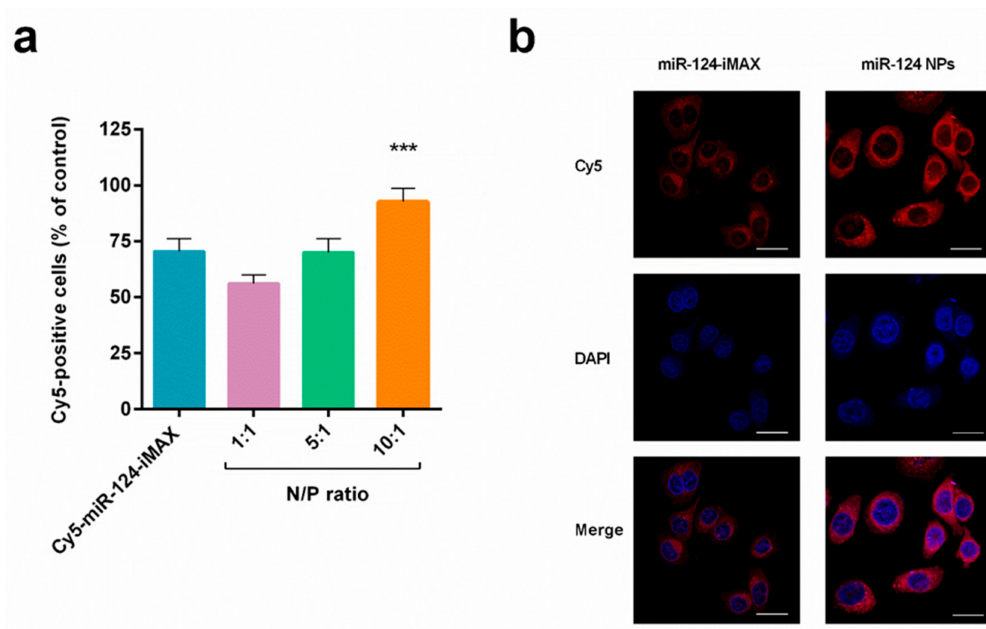
Figure 3. Intracellular delivery e ffi ciency of PHB-PEI NPs / miR-124 complexes. ( a ) PC3 uptake of miR-124 NPs analyzed by Fluorescent Activated Cell Sorting (FACS). To facilitate observations, miR-124 was labeled with the Cy5 fluorescent probe (red) to form Cy5-miR-124-NPs at di ff erent N / P ratios (1:1 to 10:1). Lipofectamine RNAiMAX (iMAX) was used as a control. Cells were incubated with fluorescent nanocomplexes for 4 h, washed with PBS, and incubated for another 20 h prior to analysis by flow cytometer (mean ± SD, n = 6). Statistically significant variations: *** p < 0.001 N / P 10:1 versus N / P 5:1, N / P 1:1, and iMAX. ( b ) Fluorescence images of PC3 cells incubated with Cy5-miR-124-NPs (N / P ratio 10:1) or Cy5-miR-124-iMAX for 4 h. Magnification 40 × , scale bar is 50 µ